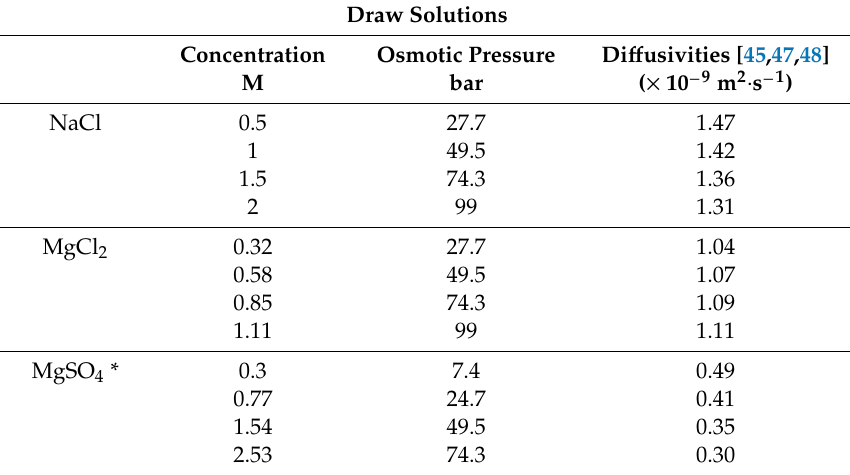
Table 3. Characteristics of draw solution (DS) used for the FO tests and for estimation of